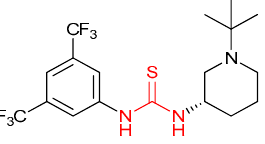
Figure 19. An example of chiral thiourea prepared in Bolm’s group [274].